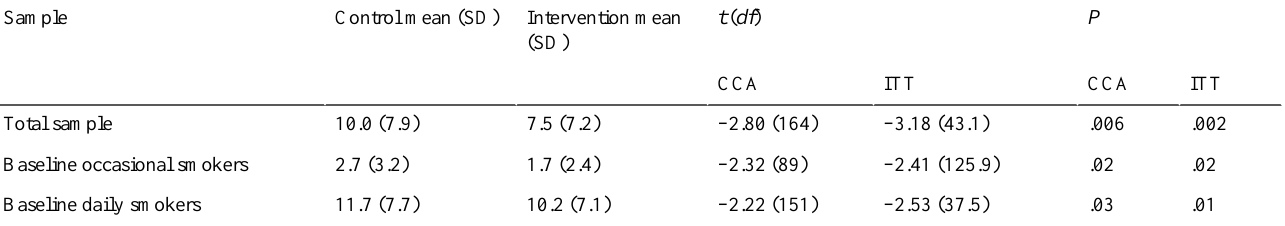
Table 3. Mean number of cigarettes smoked per day at follow-up (complete case data) and results of logistic regression analyses comparing cigarette consumption in the study groups using complete-case analyses (CCA) and intention-to-treat analyses